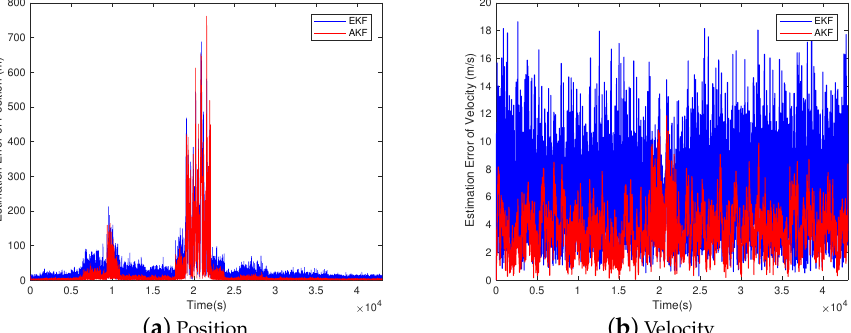
Figure 7. The figure reflects estimation error of position and velocity by EKF and AKF.